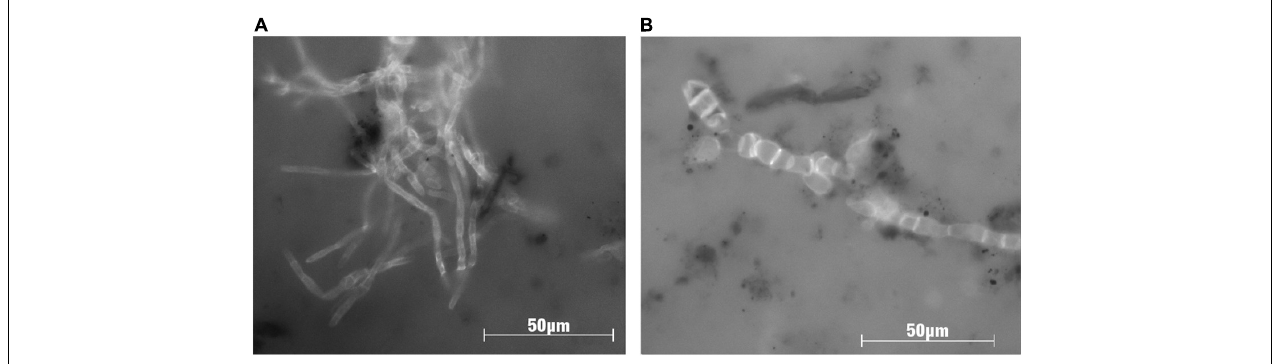
FIGURE 4 | Microphotographs of Guaymas Basin fungal strains imaged under fluorescence after calcofluor staining, which highlights the chitin cell walls of fungi. Strains were isolated from Guaymas Basin sediments ( Table 1 ), and images were taken after 40 days of incubation with the polyaromatic substrate naphthalene (5 µ g/ml) in co-culture with Desulfobacterales-dominated sulfate-reducing bacteria. Panel (A) shows growth of the filamentous ascomycete fungus Cadophora malorum , and panel (B) shows filamentous arrangement of cells of the yeast-like ascomycete fungus Aureobasidium pullulans